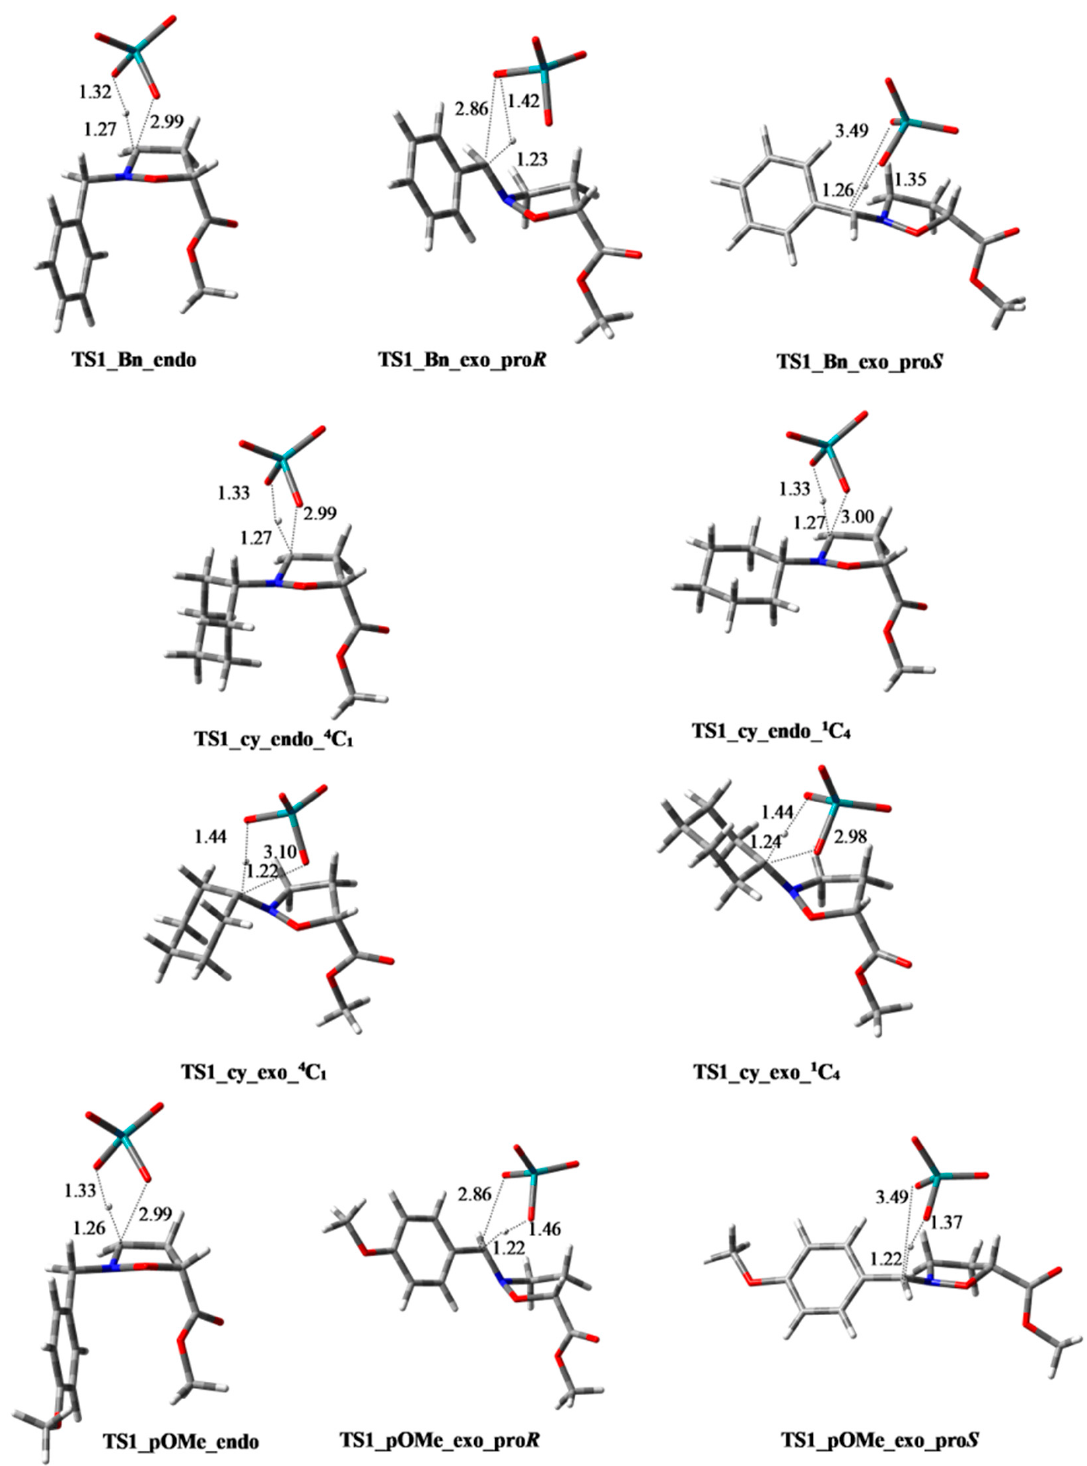
Figure 2. Three-dimensional plots of the transition states TS1 for the endo and exo pathways of compounds 1a – c . Displacement vectors for TS imaginary frequencies are shown as dotted lines and distances are reported in